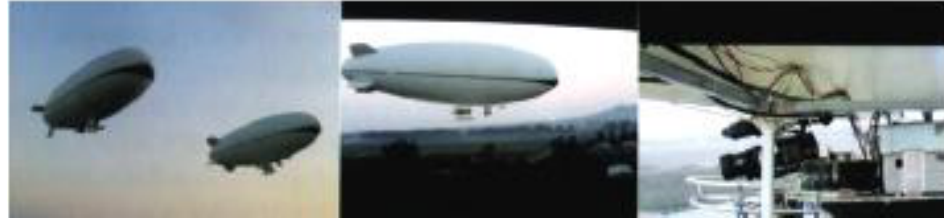
Figure 13. LWPT experiment of Shandong Aerospace Electronic Technology Research Institute. Reproduced with permission from Ref. [51]; published by IEEE, 2014.